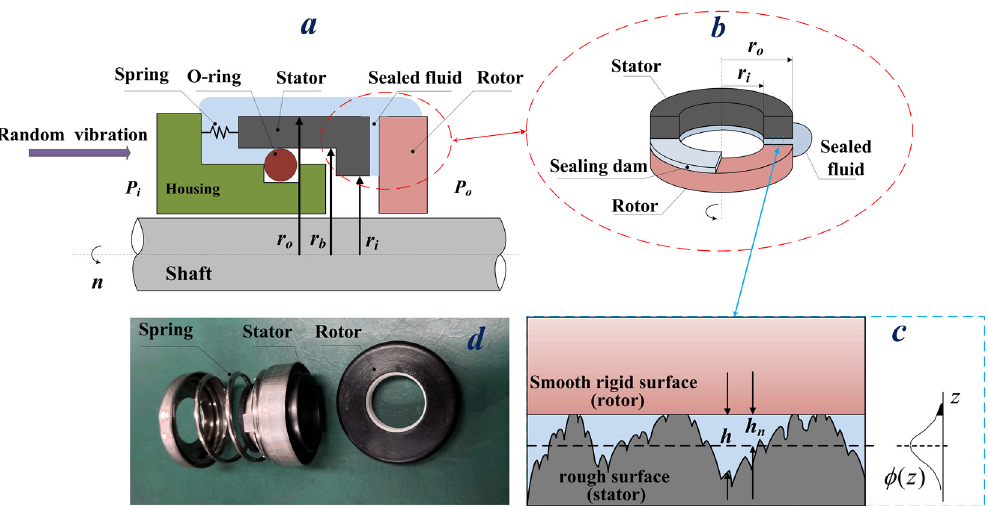
Figure 1. ( a ) Schematic of mechanical face seal; ( b ) sealing dam between the rotor and the stator; ( c ) schematic of asperity contact; ( d ) seal rings.